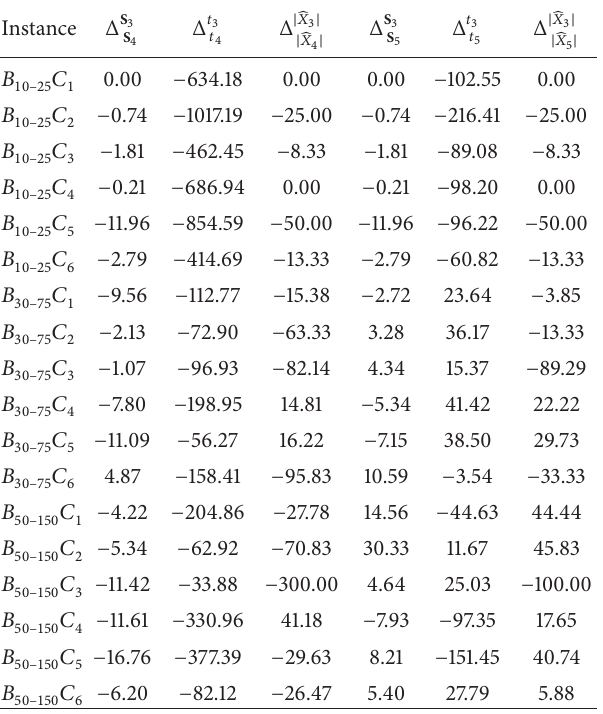
Table 10: Comparison among our BOCA with normative knowl- edge and NSGA-II and